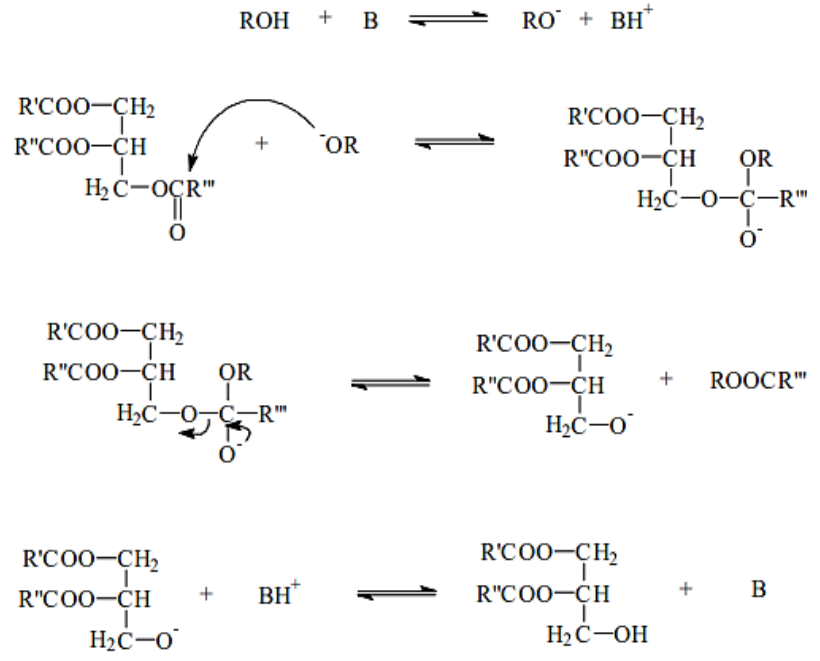
Figure 3. Mechanism of the transesterification of vegetable oils by alkali catalyst [2].